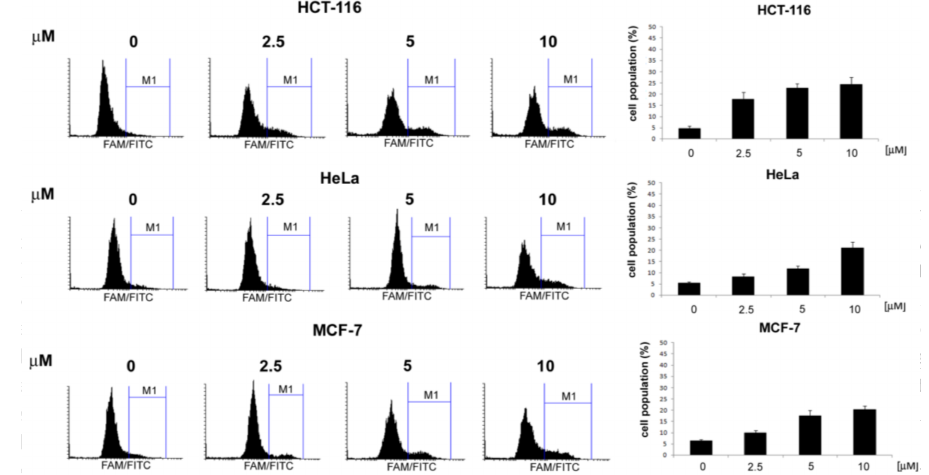
Figure 9. Induction of caspase activity by 28 in HCT-116, HeLa, and MCF-7 cells. Cells were treated with the indicated concentrations of 28 for 24 h (HCT-116) and 48 h (HeLa and MCF-7). Enzyme activity was determined using flow cytometry with the use of a caspase inhibitor, FAM-VAD-FMK. Values represent mean ± SD of three independent